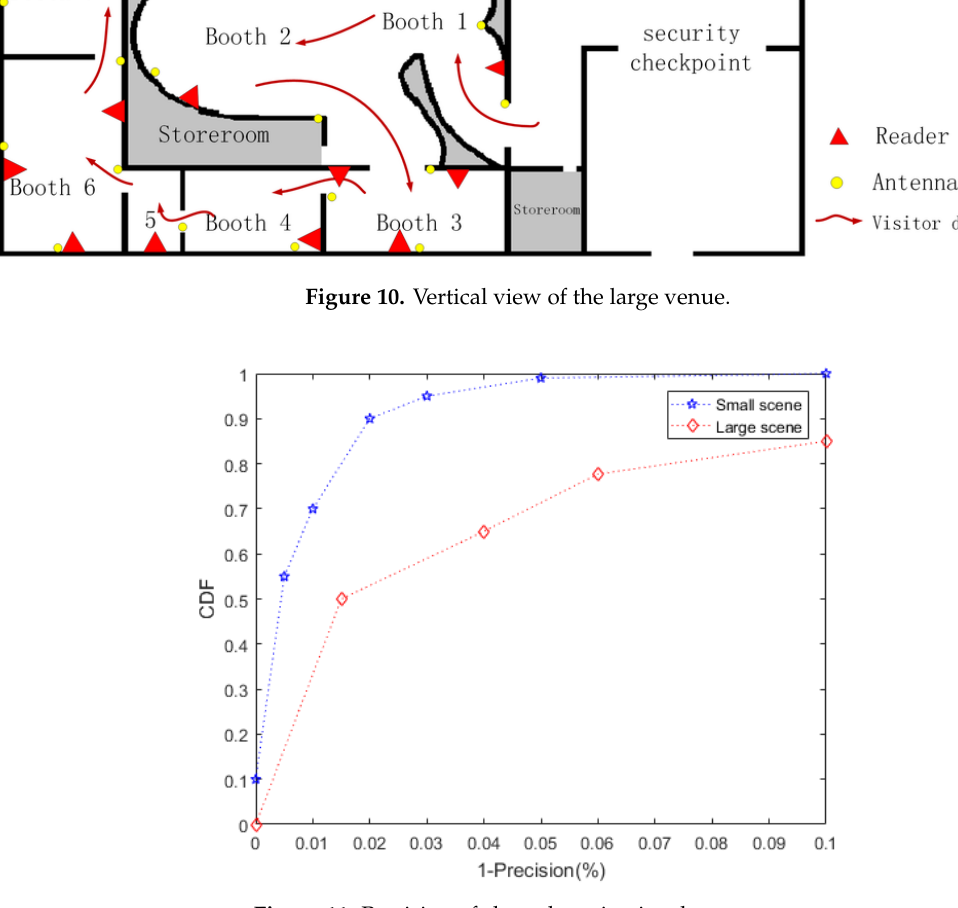
Figure 11. Precision of clone detection in a large area.